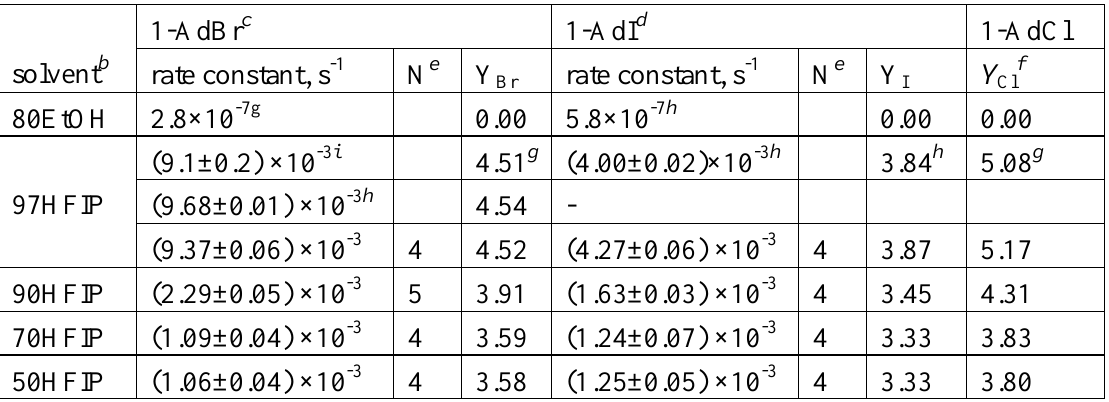
Table 1. Specific rates of solvolyses of 1-adamantyl halides a in 80% ethanol and HFIP-H at 25.0°C and new solvent ionizing power values ( Y